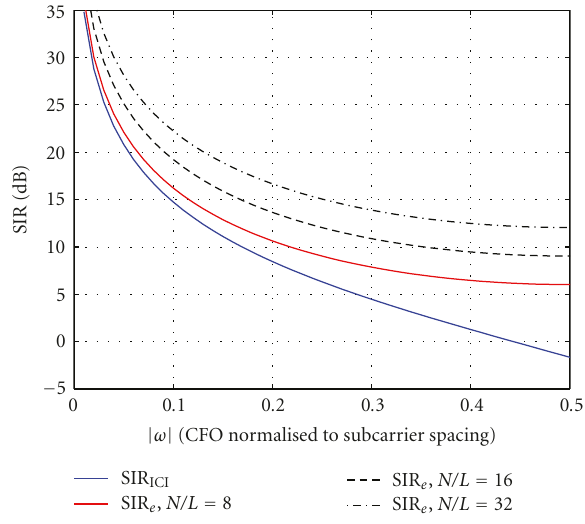
Figure 1: SIR conditions for uncompensated CFO (12) and compensated CFO (28) based on the signal model in